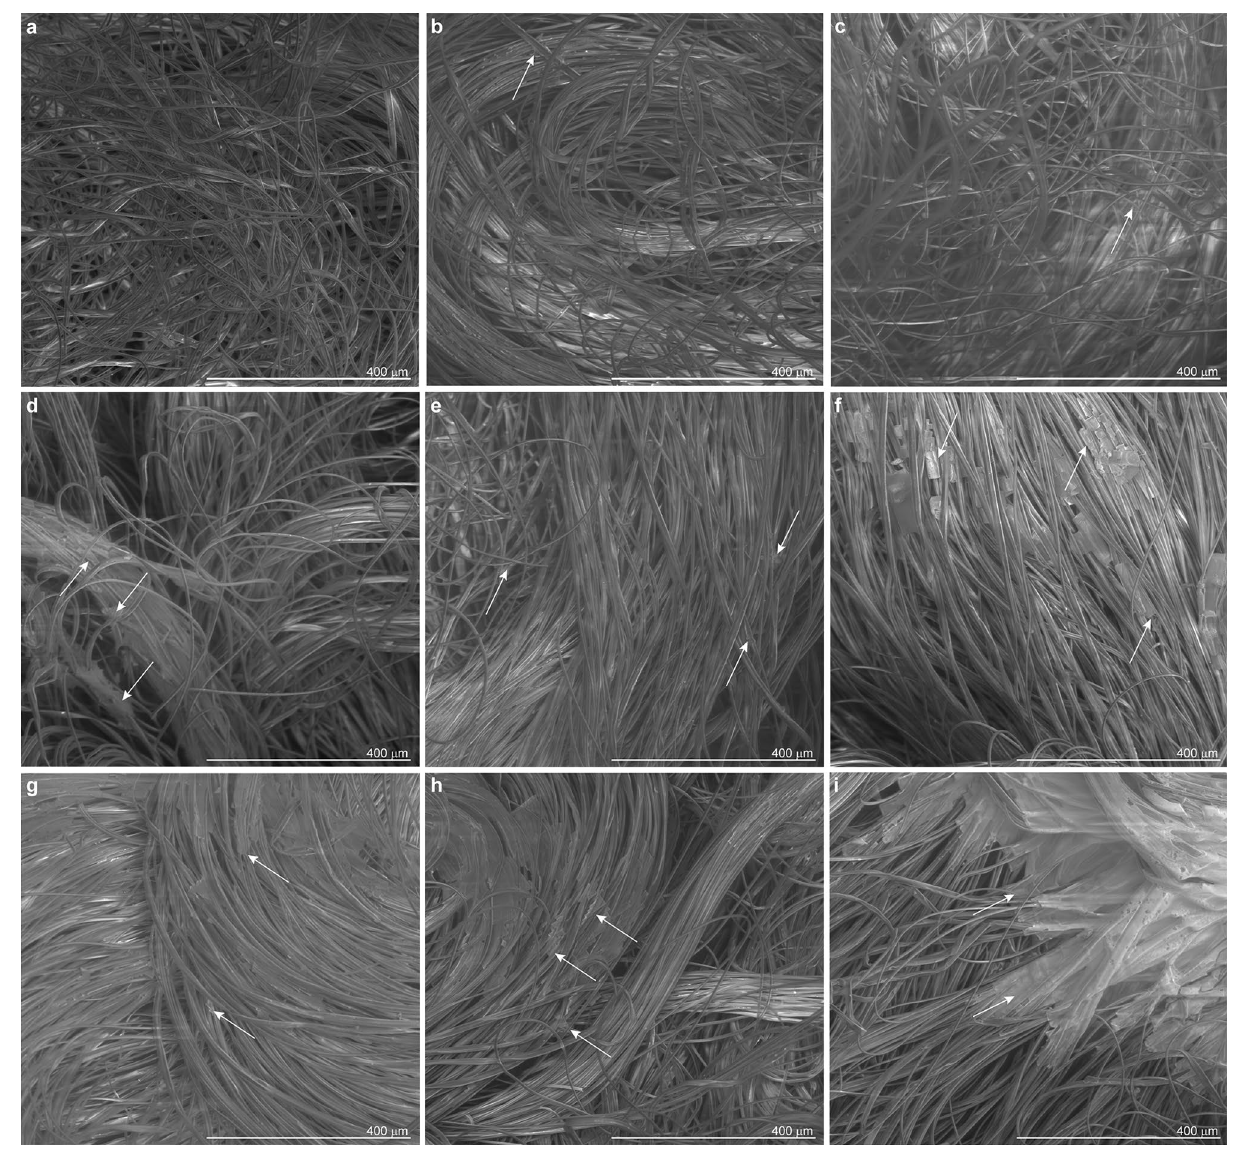
Figure 2. Scanning electron microscopic images of test material, salt-coated by spray and dip methods. The salt formulation was used non-diluted or diluted. Spray treatments allowed the deposition of increasing amounts of salt by varying the valve aperture of the spray device according to arbitrary stroke units. ( a ) Non-coated, ( b ) spray, undiluted salt formulation, stroke unit 1 (Spr S1), ( c ) spray, fivefold diluted salt formulation, stroke unit 3 (Spr S3 Dil5 ×), ( d ) spray, undiluted salt formulation, stroke unit 3 (Spr S3), ( e ) spray, undiluted salt formulation, stroke unit 5 (Spr S5), ( f ) spray, undiluted salt formulation, stroke unit 10 (Spr S10). For dip treatments test materials were immersed into ( g ) tenfold diluted (Dip Dil10 ×), ( h ) fivefold diluted (Dip Dil5 ×), and ( i ) undiluted (Dip No Dil) salt formulations. Arrows on images point at examples of salt crystals and aggregates found on the test